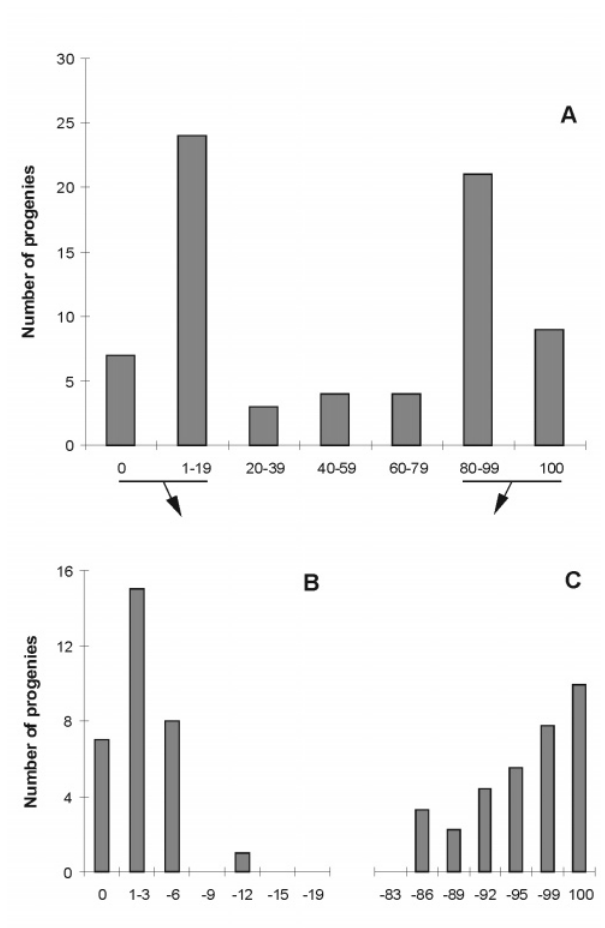
Figure 1 - Progeny sex ratio distribution in females (N = 72) from a labora- tory population of B. matogrossensis . A, Frequency distribution of fe- males according to the sex ratio of their progenies, expressed as the pro- portion of males/progeny. The all-female and all-male classes were iso- lated and the bisexual progenies were grouped into five classes of 20% intervals. The female- and male-skewed classes (indicated by horizontal bars) were reanalyzed using smaller class intervals (3%) (panels B and C, respectively). Note the decreasing frequency of two-sex progenies as the number of the rare, opposite sex